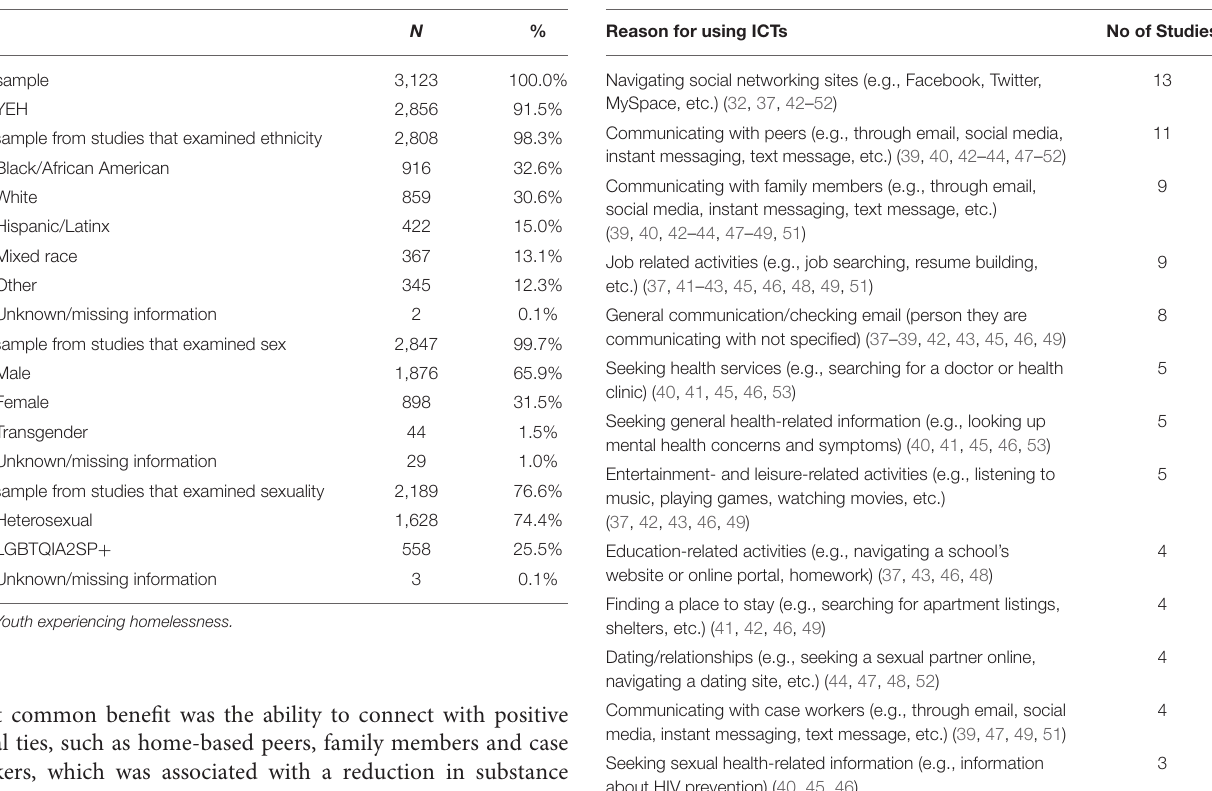
TABLE 1 | Participant sociodemographics.